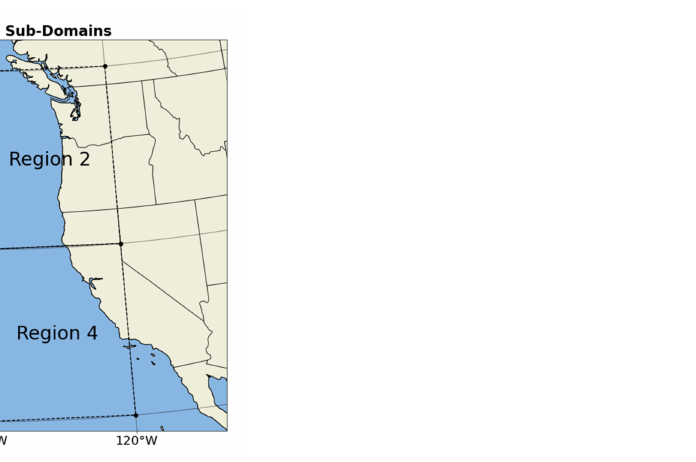
Figure 1. The target area of the Constellation Observing System for Meteorology Ionosphere, and (COSMIC) vertical profiles collected in this study. Four sub-domains were created for further analysis of regional meteorological variables, as seen in Sections